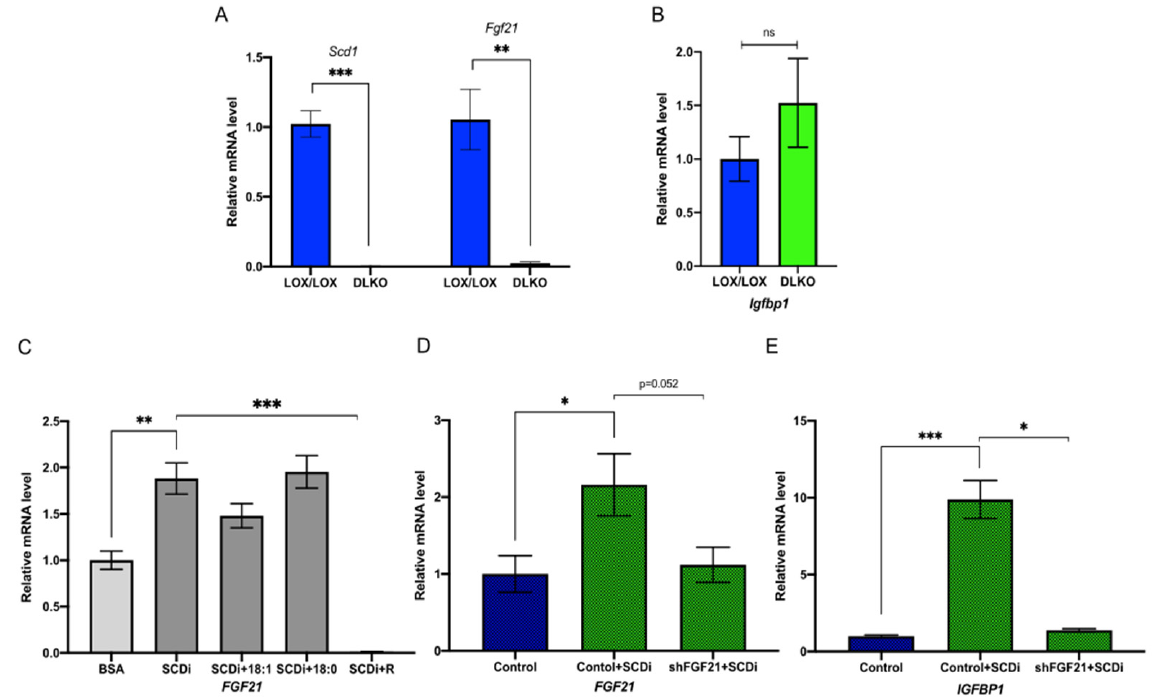
Figure 4. IGFBP1 is regulated by SCD1 through the mTORC1-FGF21 axis. ( A ) Relative hepatic Scd1 and Fgf21 mRNA levels in LOX/LOX (n = 6, 3 male; 3 female) and DLKO (n = 6, 3 male; 3 female) mice fed HCD for 10 days. ( B ) Relative hepatic Igfbp1 mRNA level in LOX/LOX (n = 6, 3 male; 3 female) and DLKO mice fed HCD (n = 6, 3 male; 3 female) for 10 days. ( C ) Relative Fgf21 mRNA level in HepG2 cells treated with BSA (n = 6), BSA plus 1 µ M SCD inhibitor (n = 6), BSA plus 1 µ M SCD inhibitor and 100 µ M oleic acid (n = 5), BSA plus 1 µ M SCD inhibitor and 100 µ M steric acid (n = 5), BSA plus 1 µ M SCD inhibitor and rapamycin (n = 5). ( D ) Relative FGF21 mRNA level in HepG2 cells treated with control lentiviral particles (n = 6), control lentiviral particles plus SCD inhibitor (n = 6), or shFGF21 lentiviral particles plus SCD inhibitor (n = 6). ( E ) Relative IGFBP1 mRNA level in HepG2 cells treated with control lentiviral particles (n = 6), control lentiviral particles plus SCD inhibitor (n = 5), or shFGF21 lentiviral particles plus SCD inhibitor (n = 5). Values are mean ± SEM; ns = not significant; * p < 0.05 vs. LOX/LOX, BSA, or control; ** p < 0.01 vs. LOX/LOX, BSA, or control; *** p < 0.005 vs. LOX/LOX, BSA, or control by Student ′ s two-tailed t -test.